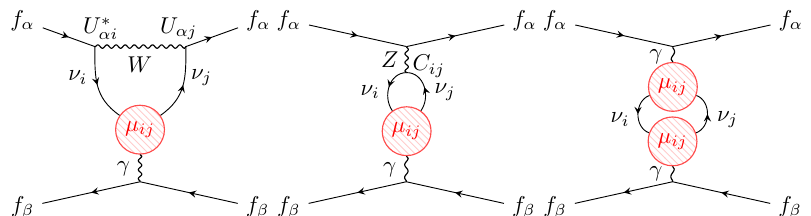
Figure 5 . Left and centre : diagrams depicting the exchange of two massive neutrinos between fermions f (cid:11) and f (cid:12) with SM CC and NC interactions at one vertex and the exchange of a photon via a neutrino magnetic moment (cid:22) ij at the other, leading to the vector-dipole potential V V (cid:13) ( r ). (cid:11)(cid:12) Right : diagram when a magnetic dipole moment is present at both vertices, resulting in the dipole- dipole potential V (cid:13)(cid:13) ( r ). (cid:11)(cid:12) where the antisymmetric matrices (cid:22) M and (cid:22) M contain the transition dipole moments for the (cid:23) N light and heavy neutrino mass eigenstates respectively, while (cid:22) M contains the (cid:23)N